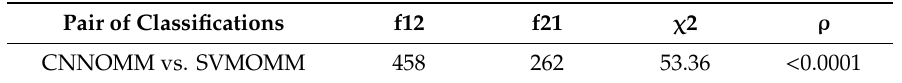
Table 7. McNemar’s test results for OMM. fij: the numbers of objects that were correctly classified